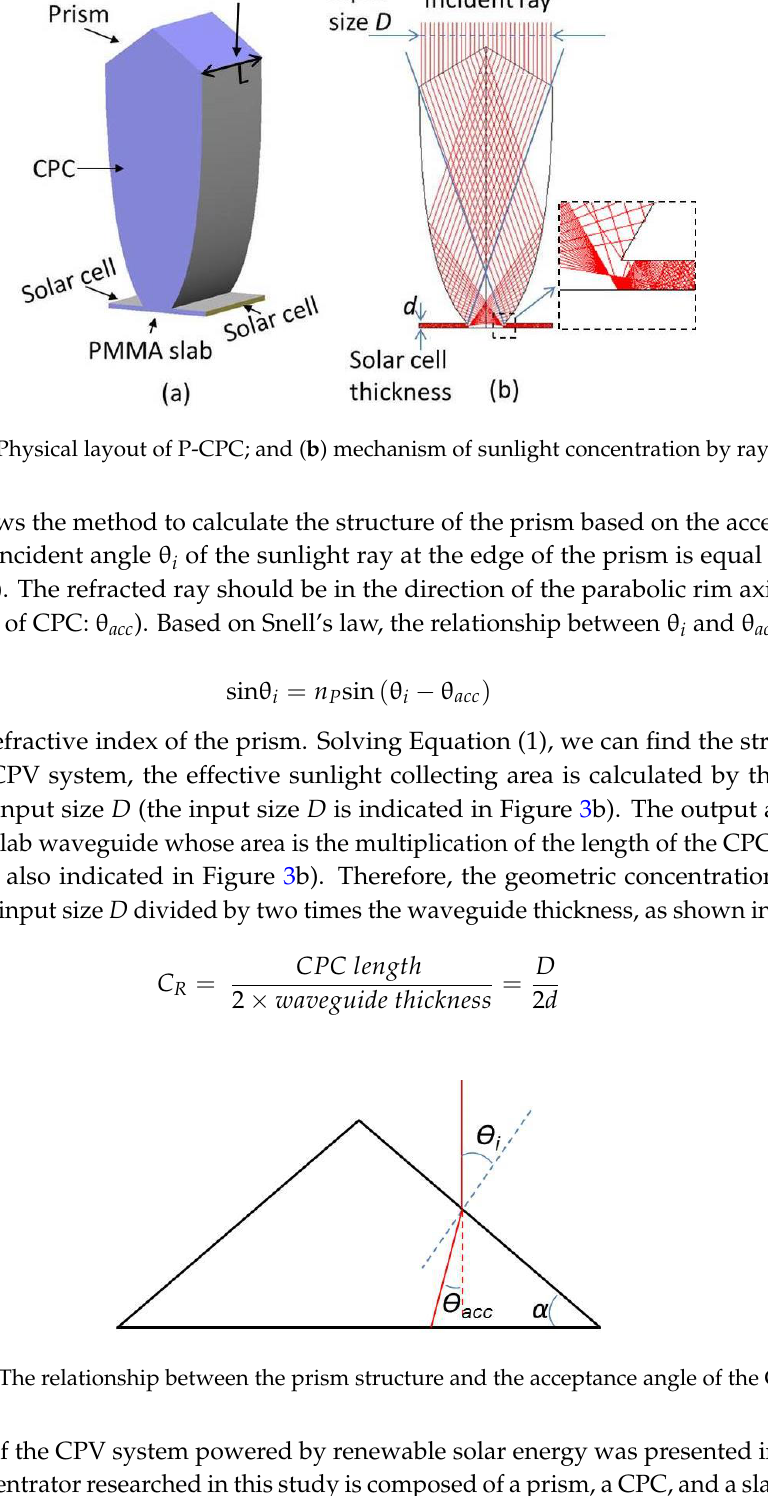
Figure 4. The relationship between the prism structure and the acceptance angle of the CPC.